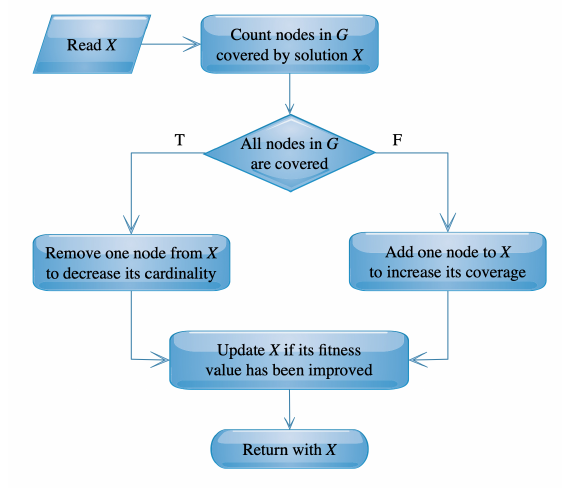
Figure 2. Main steps of local